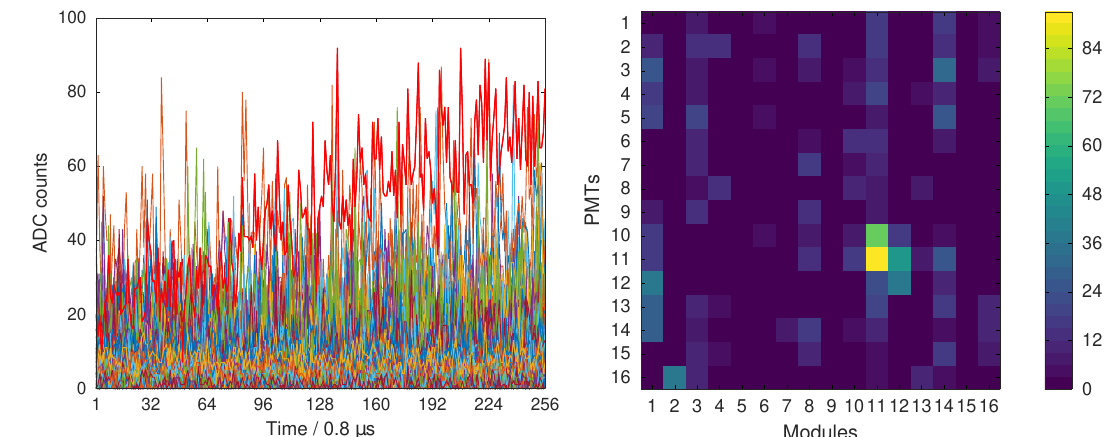
Figure 16. An event registered above North Canada on 3 November 2016, and seemingly mistakenly selected by the CNN as a slow